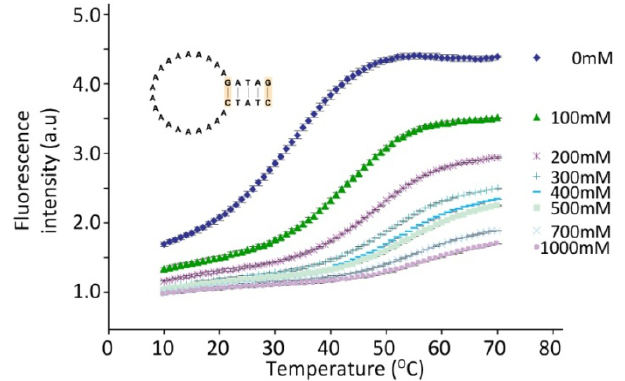
Figure 4. Influence of NaCl on hairpin melting. Melting curves are shown for a DNA hairpin subjected to increasing concentrations of NaCl as indicated. The hairpin has a 20 bases long poly-A loop and a five base-pair stem. Standard deviations of fluorescence values are shown as error bars. The hairpin sequence is as